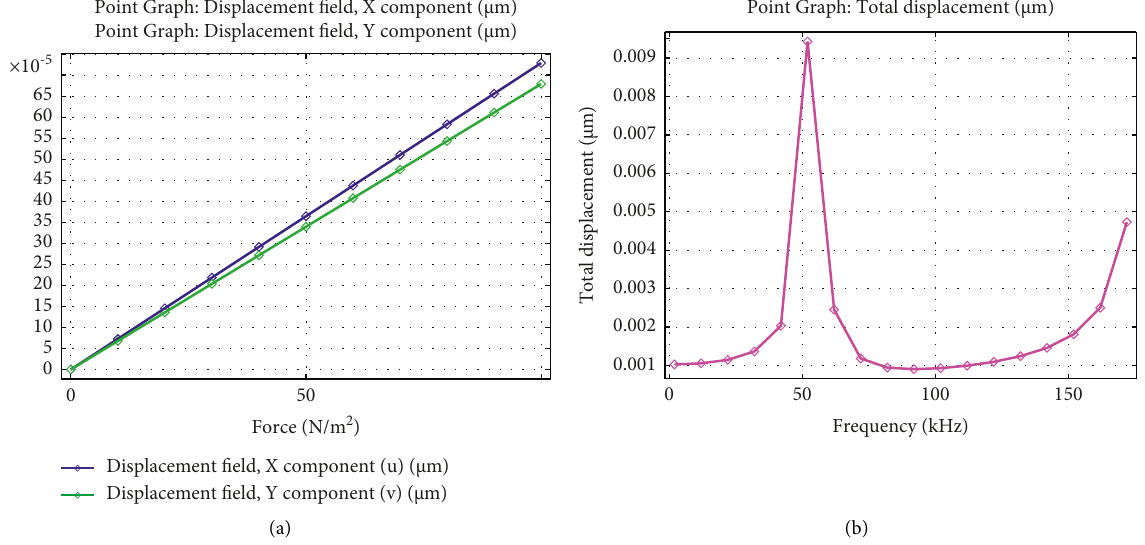
Figure 11: (a) Displacement characteristics; (b) natural frequency for the proposed sensor 5.